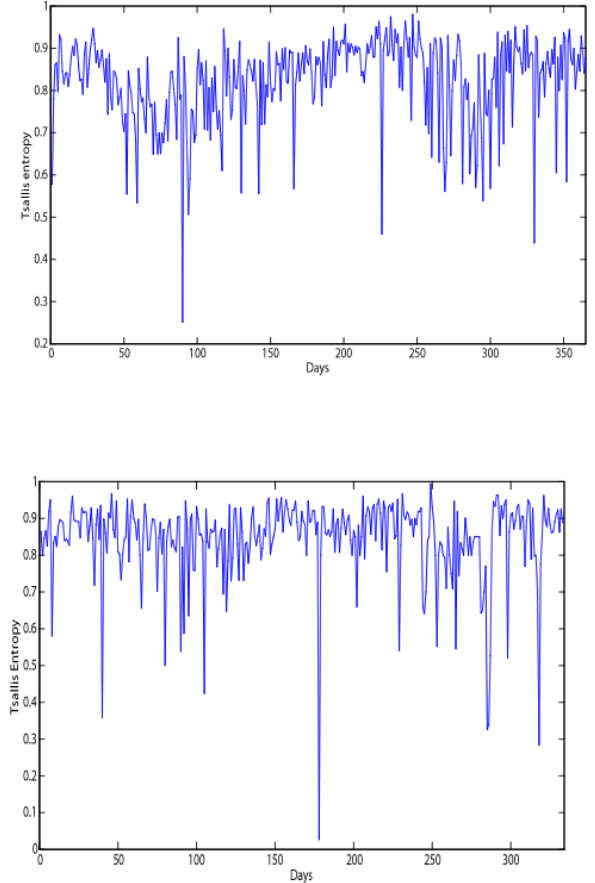
Figure 9. (a) The transient variations of Tsallis entropy for 365 days (1 January–30 November) of 2011 for detrended TEC measured at Enugu. (b) The transient variations of Tsallis entropy for 334 days (1 January–30 November) of 2011 for detrended TEC measured at